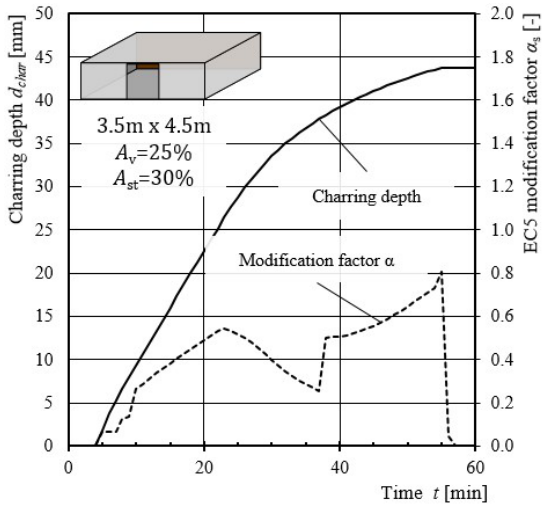
Figure 16: Predicted charring depth and modification factor α